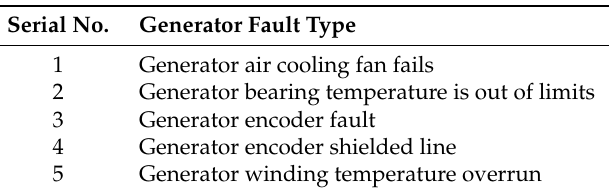
Table 2. Main faults of generator.